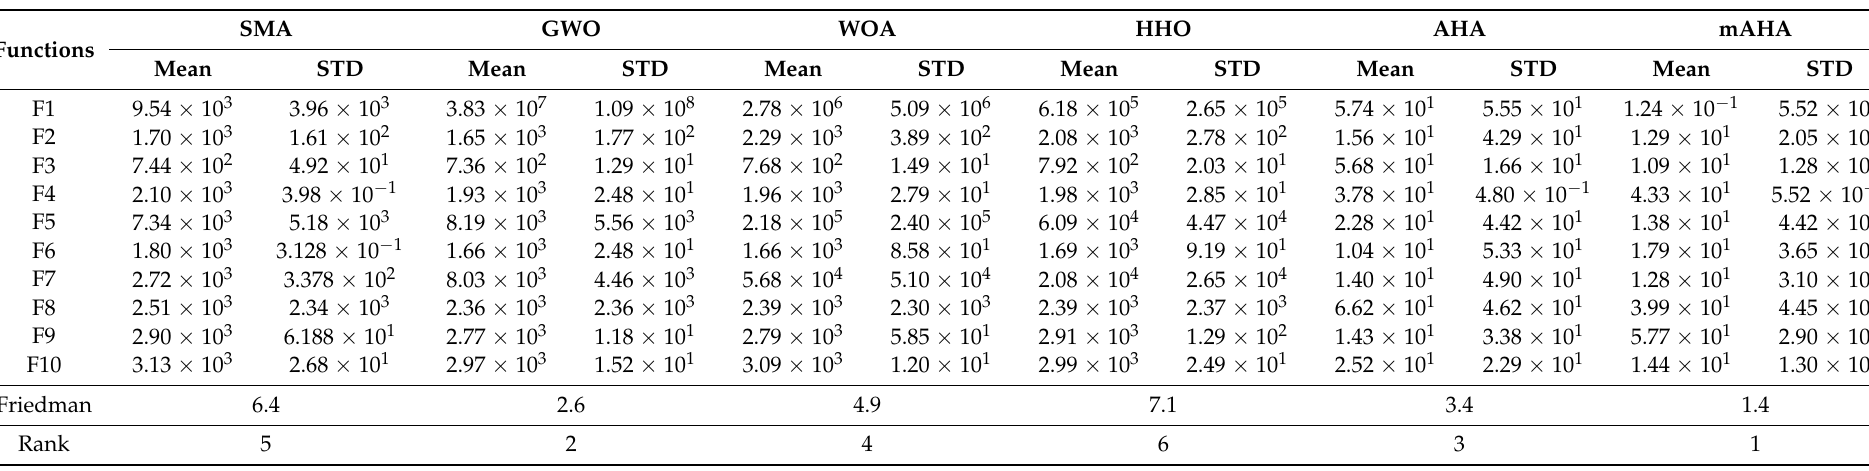
Table 2. The statistical results on the CEC’20 test suite have been obtained by the proposed mAHA and the competitor algorithms for 30 runs with Dim